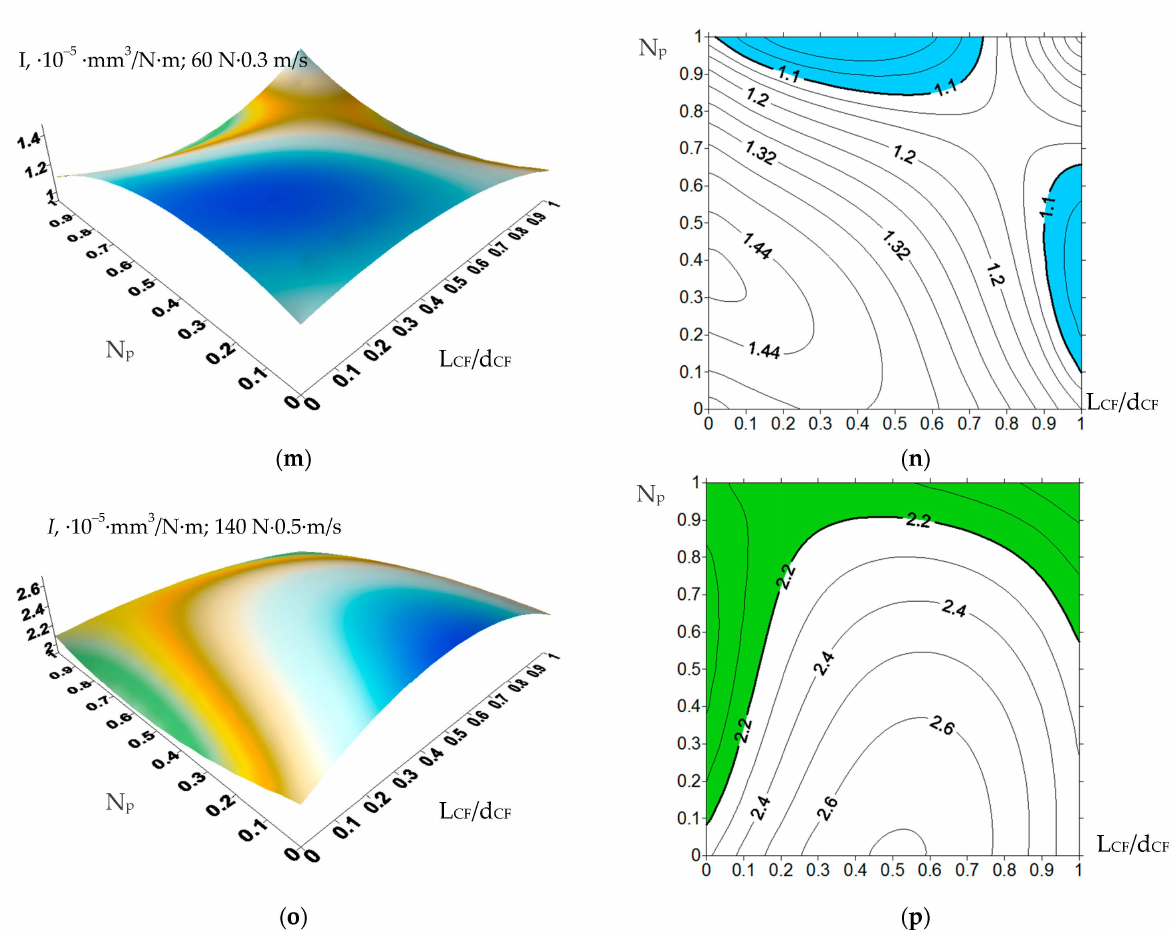
Figure 12. The functional properties of the UHMWPE-based composites vs. the number of processing passes in the extruder and the aspect ratio: ( a , b ) tensile Young’s modulus E (MPa); ( c , d ) ultimate tensile strength σ T (MPa); ( e , f ) yield strength σ Y (MPa); ( g , h ) elongation at break ε (%); ( i , j ) wear rate I (10 − 6 · mm 3 /N · m) (the ‘ball-on-disk’ scheme; the ‘mild’ tribological conditions); ( k , l ) the friction coefficient f; ( m , n ) wear rate I · (10 − 5 mm 3 /N · m) (the ‘block-on-ring’ scheme; the ‘mild’